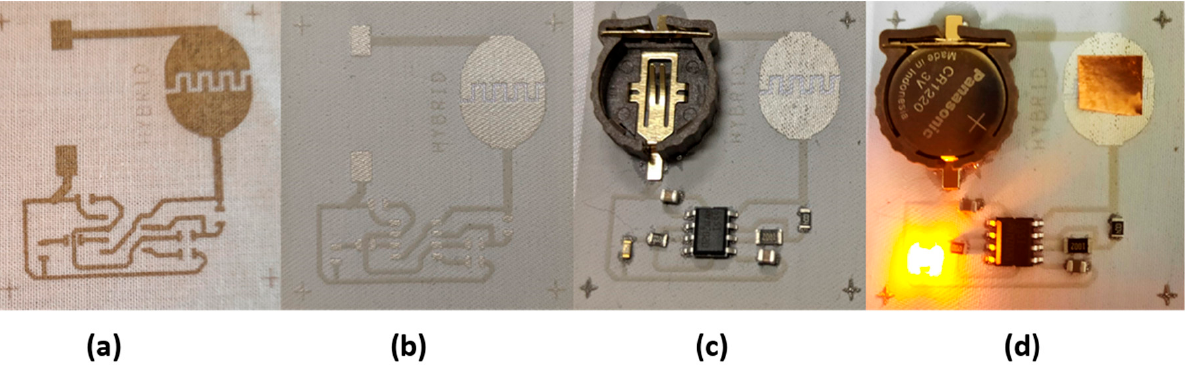
Figure 16. Image of oscillator circuit: ( a ) layout, ( b ) solder mask, ( c ) Toff oscillator time, and ( d ) Ton oscillator time.